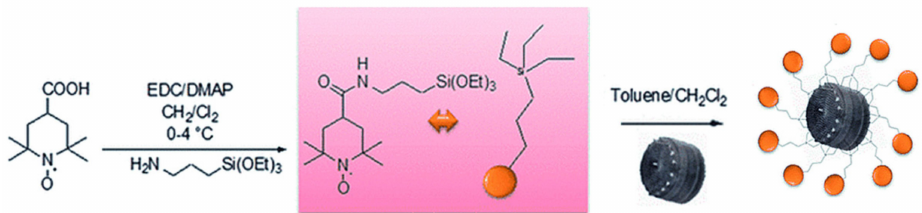
Figure8. NO-releasingdiatomaceousearthderivatizationschematicfeaturingAPTESasarepresentative silane. Reprinted with permission from [76], copyright (2017), American Chemical